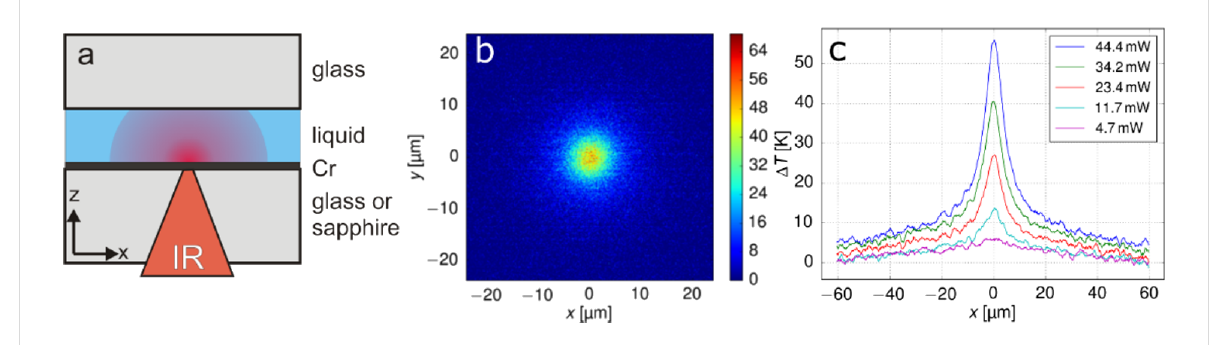
Figure 1: Experimental chamber and laser-induced heating. (a) Chamber cross section. A 5 μ m thick liquid layer is sandwiched between a chromium- coated glass or sapphire substrate and a top coverslip. A focused IR laser beam is absorbed in the Cr layer, thus creating a hot spot. (b) Fluid temper- ature field for P las = 44 mW and (c) temperature profiles through the center of the hot spot for different laser powers on a sapphire